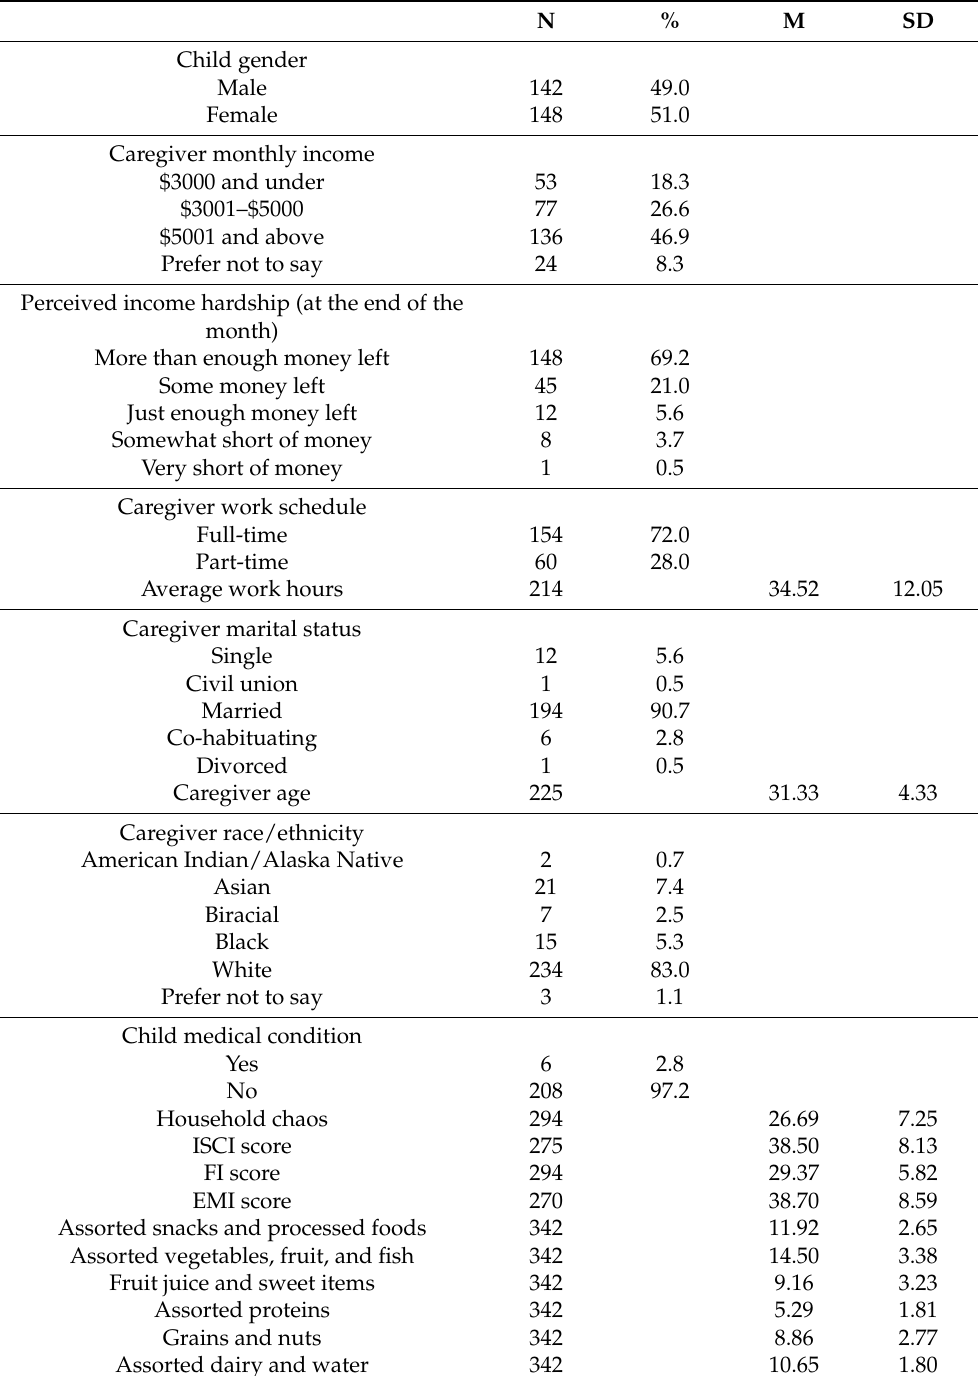
Table 1. Descriptive Statistics for Model